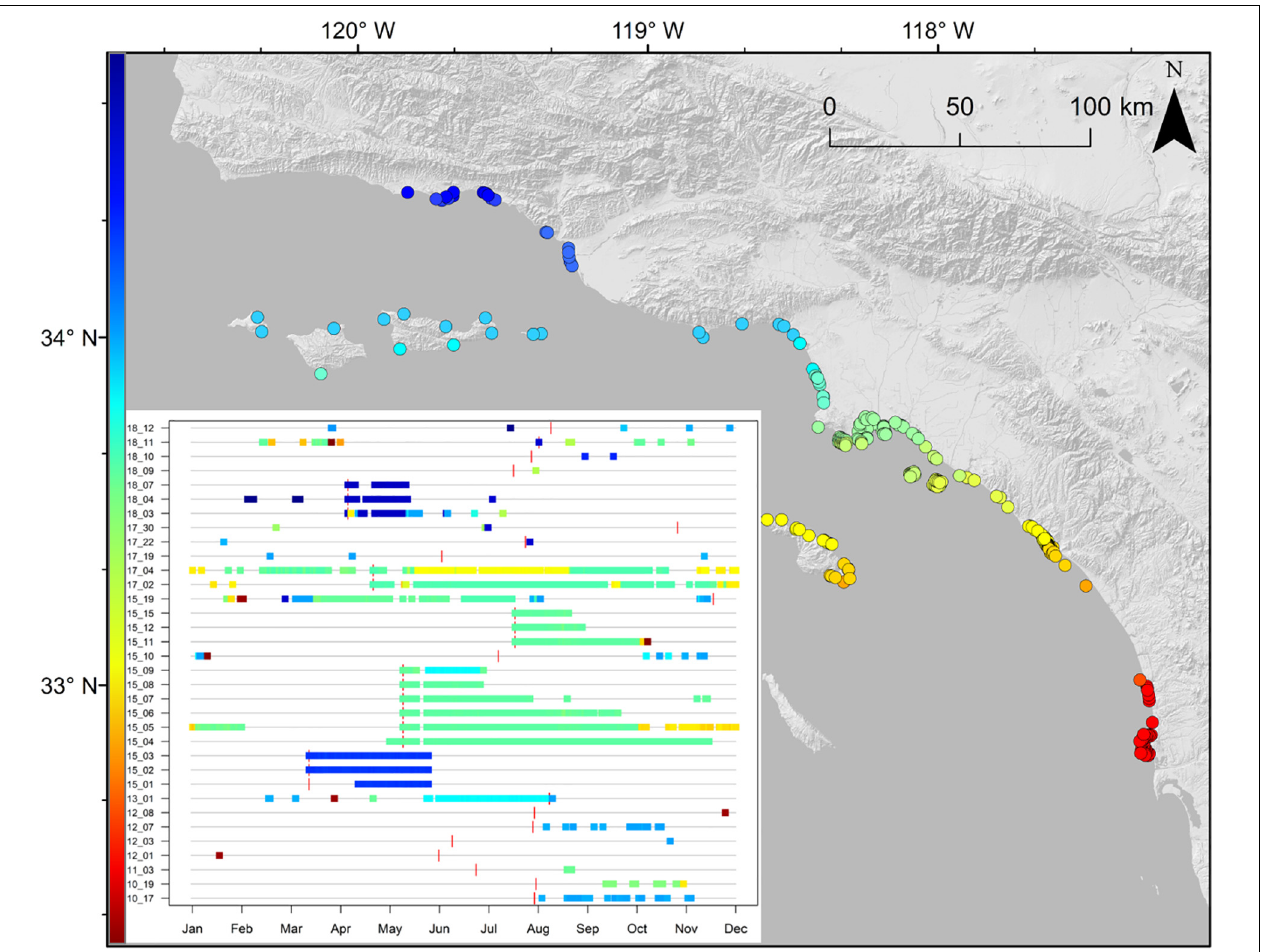
FIGURE 3 | Map of receiver station locations in southern California, with presence-absence plot inset of YOY white sharks acoustically detected during the study period, where each individual is centered on a generic year, and the vertical red bar denotes tagging date of that year, rather than chronologically (2010–2018). Shading indicates latitude of receiver(s) a shark was detected on. The first two digits for each individual in this inset plot indicate tagging year (e.g., 10_17 and 18_12 indicate these two individuals were tagged in 2010 and 2018, respectively).